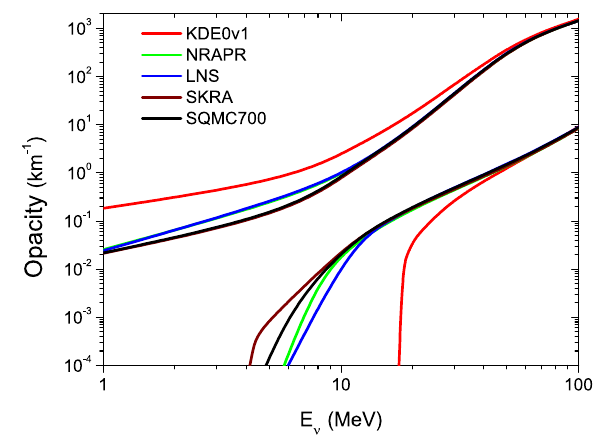
Figure 5. (Color online) Opacity for neutrino and antineutrino, evaluated at conditions ρ = 0 . 02fm − 3 , T = 8MeV, and Y p = 0 . 029 with the di ff erent Skyrme